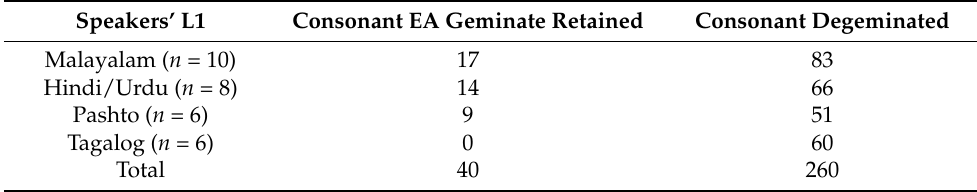
Table 4. Consonant EA gemination vs. degemination based on speakers’ L1.